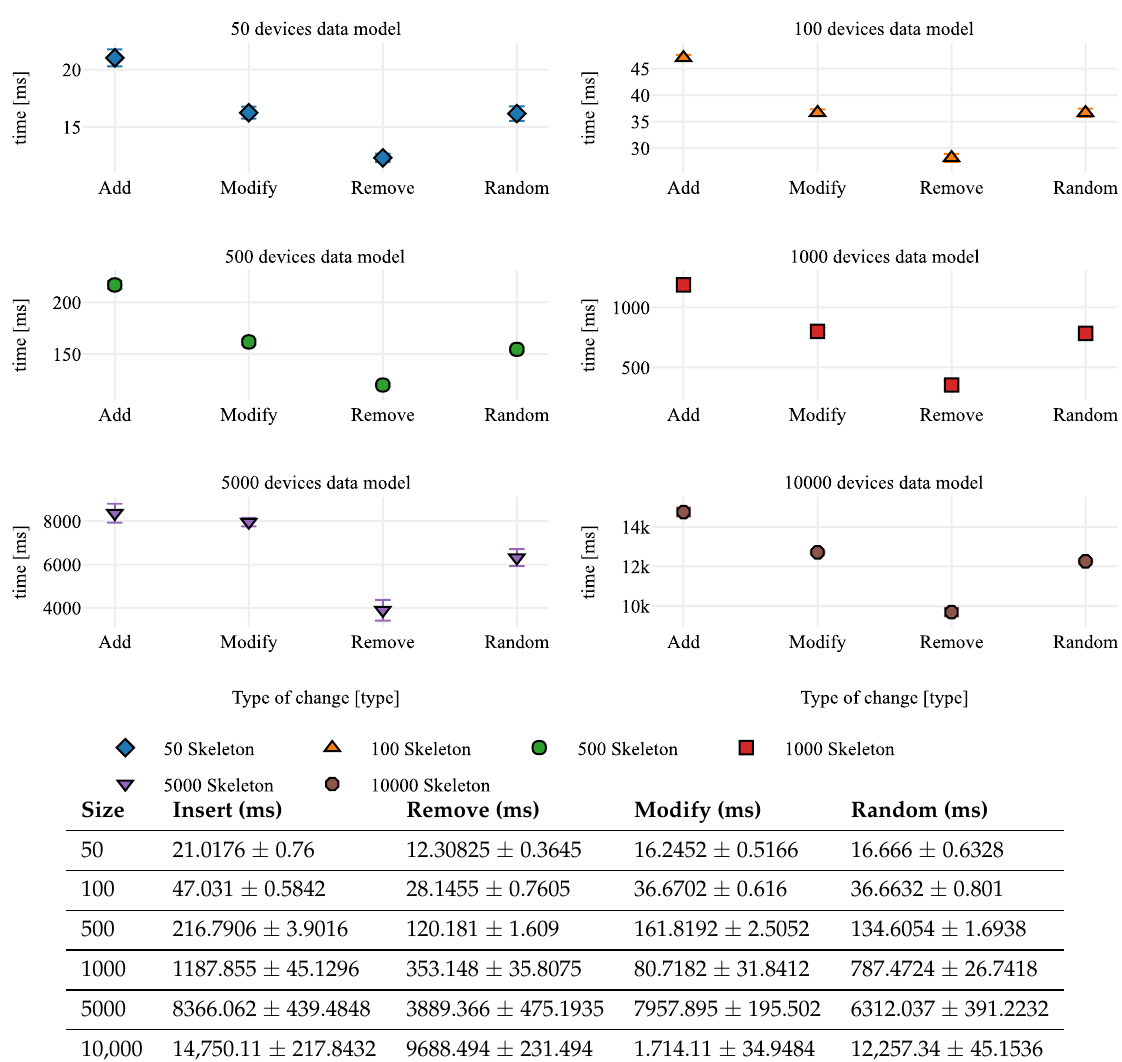
Figure 6. The execution time averages in different ICPS Data Model sizes.